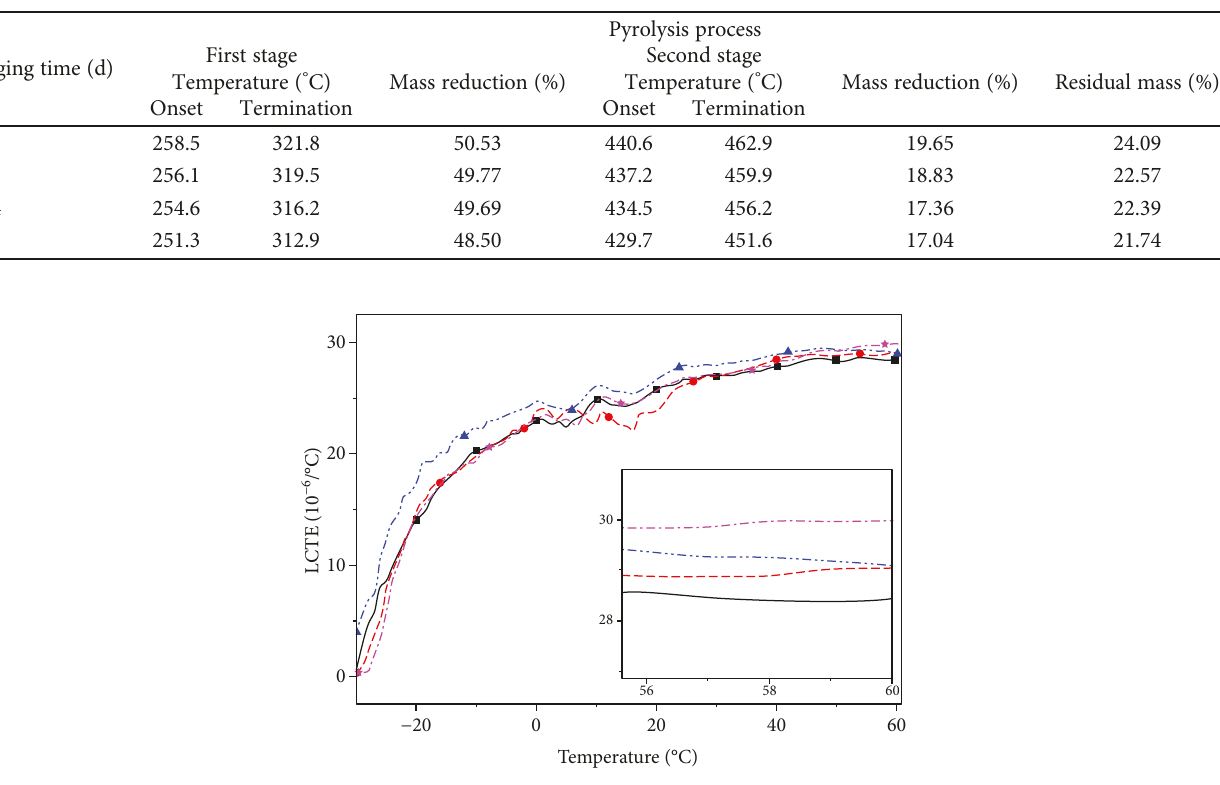
Table 6: Pyrolysis characterization data of the PVC/RHF composites.